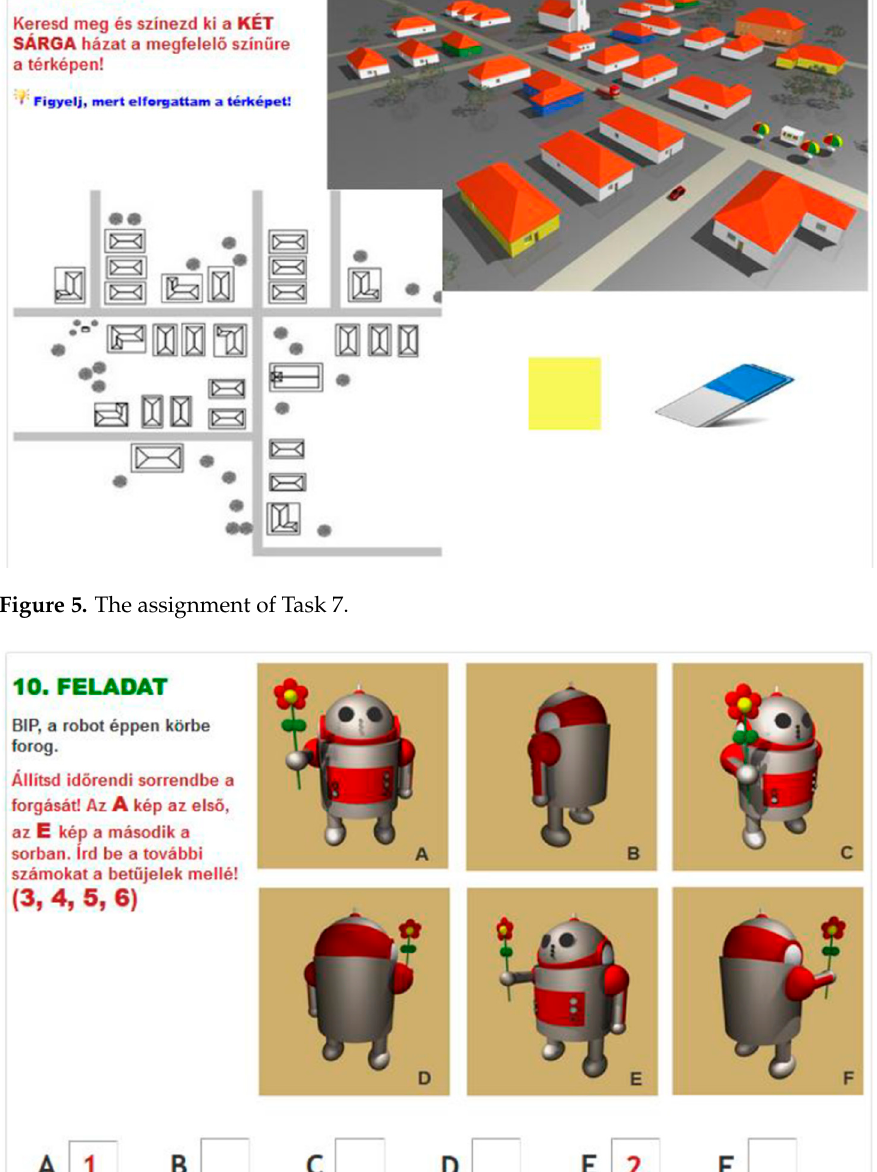
Figure 6. The assignment of Task 10.